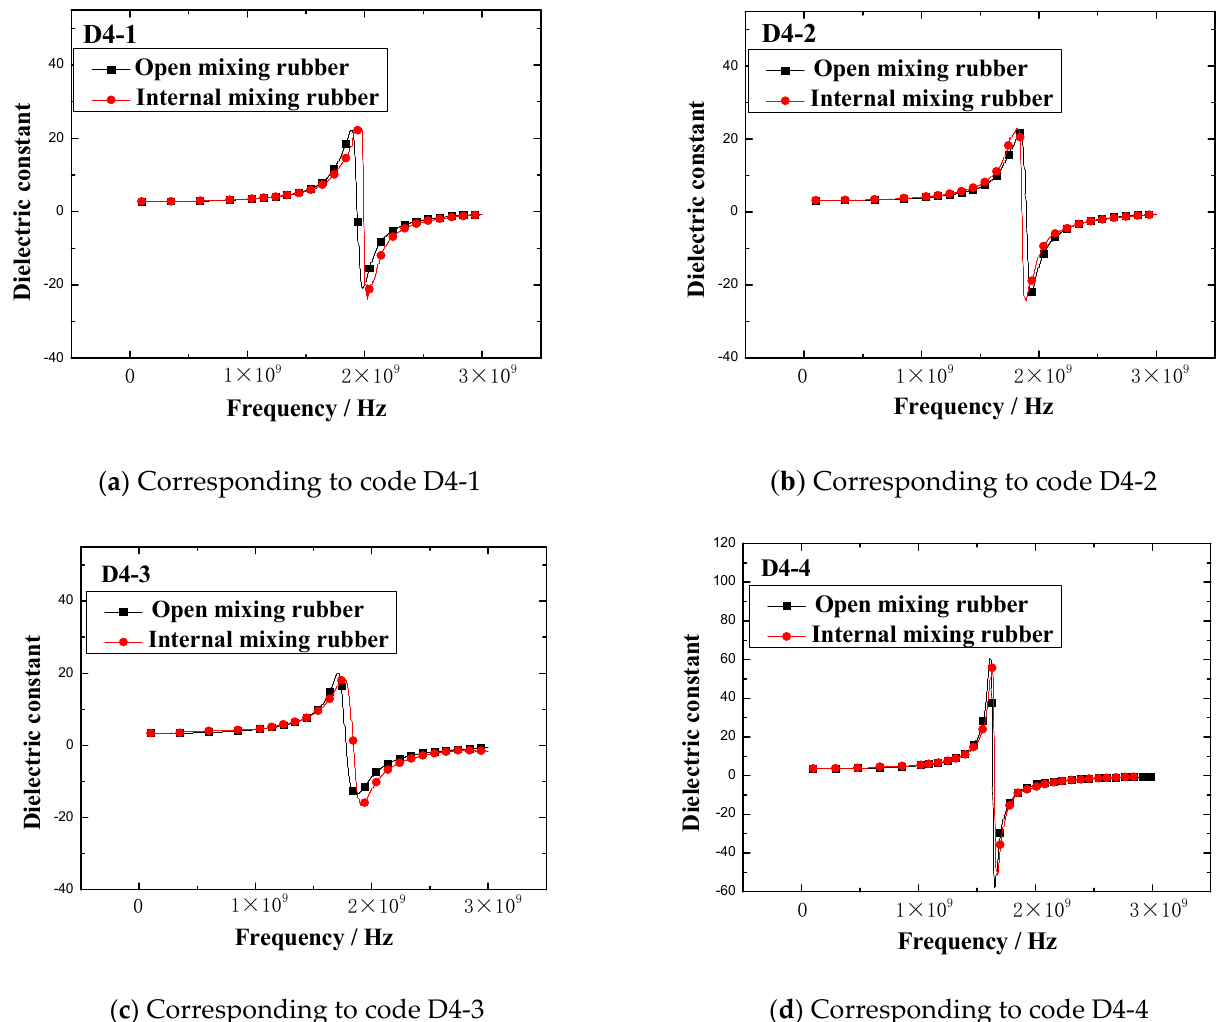
Figure 5 indicates that no matter what kind of mixing method, the trend of the die-